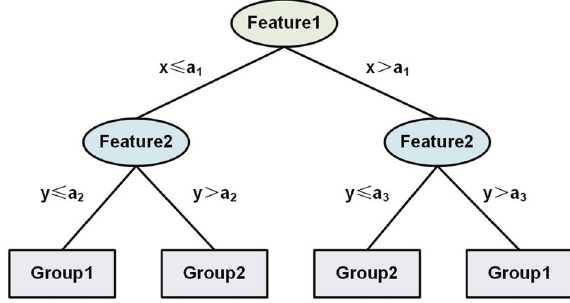
Fig. 6 An illustration of a simple decision tree